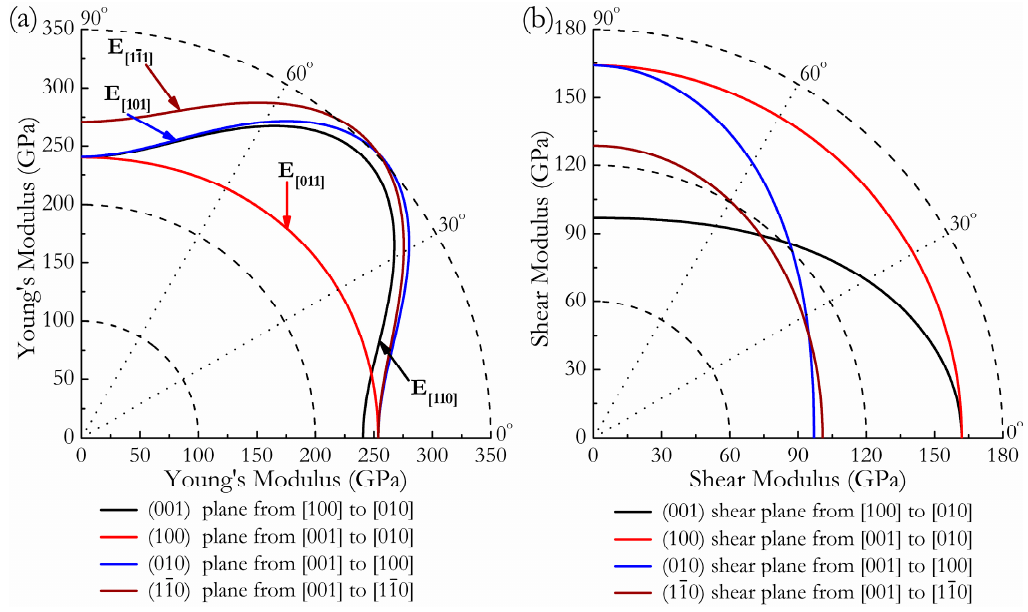
Figure 4. Orientation dependences of the Young’s modulus E ( a ) and shear modulus G ( b ) for Cmmm -Ir 2 Zr.